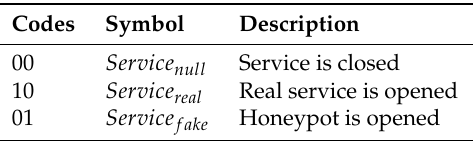
Table 2. The illustration of 01